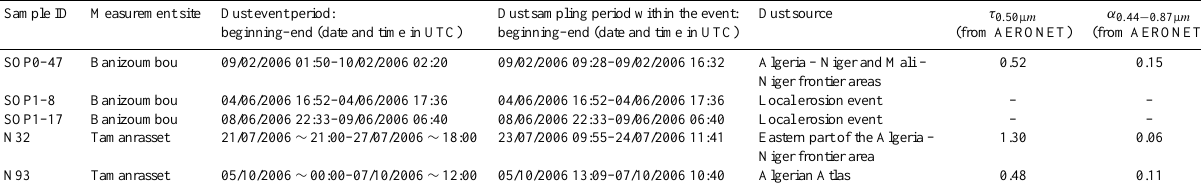
Table 1. Main characteristics of the five dust cases selected in this study: the sample ID, the measurement site, the date and time of beginning and end of the observed dust event, the associated filter sampling time interval within the event, and the identified dust source region. The mean aerosol optical depth ( τ) at 0.50µm and the Ångstrom exponent ( α , calculated between 0.44 and 0.87µm) obtained from AERONET (Aerosol Robotic Network) measurements during filter sampling for the different cases are also reported; no data are available for the SOP1– 8, when the solar zenith angle at the start of the sampling was >70 ◦ , and for the SOP1–17, which corresponds to night-time data (UTC, Universal Time